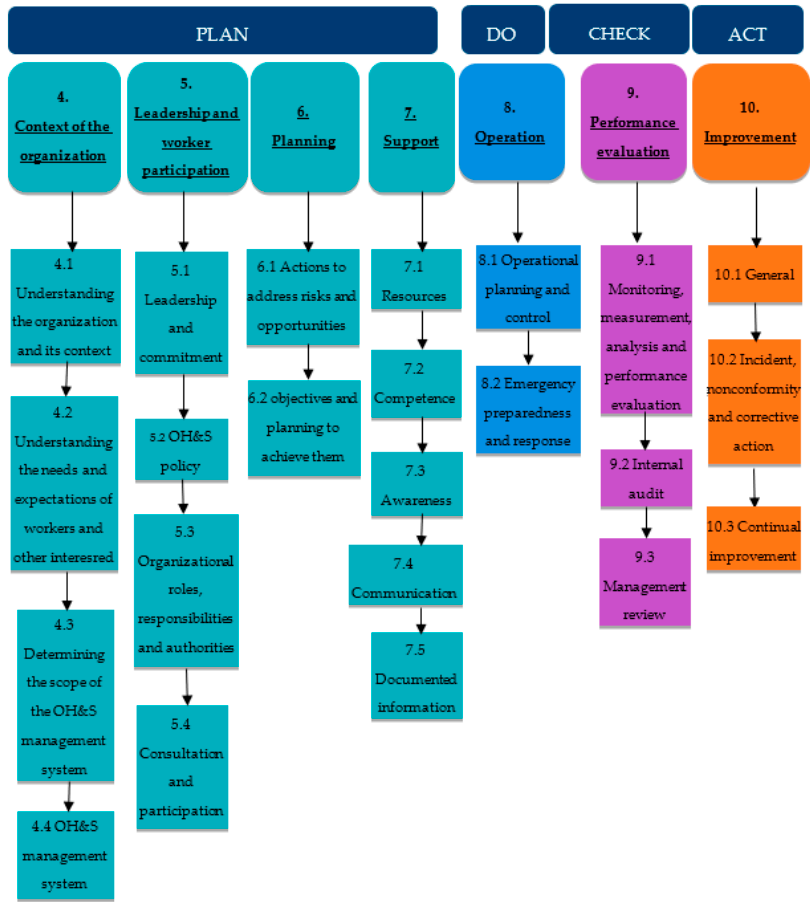
Figure 3. The structure of the OH&S according to ISO 45001 from the point of view of PDCA [25].